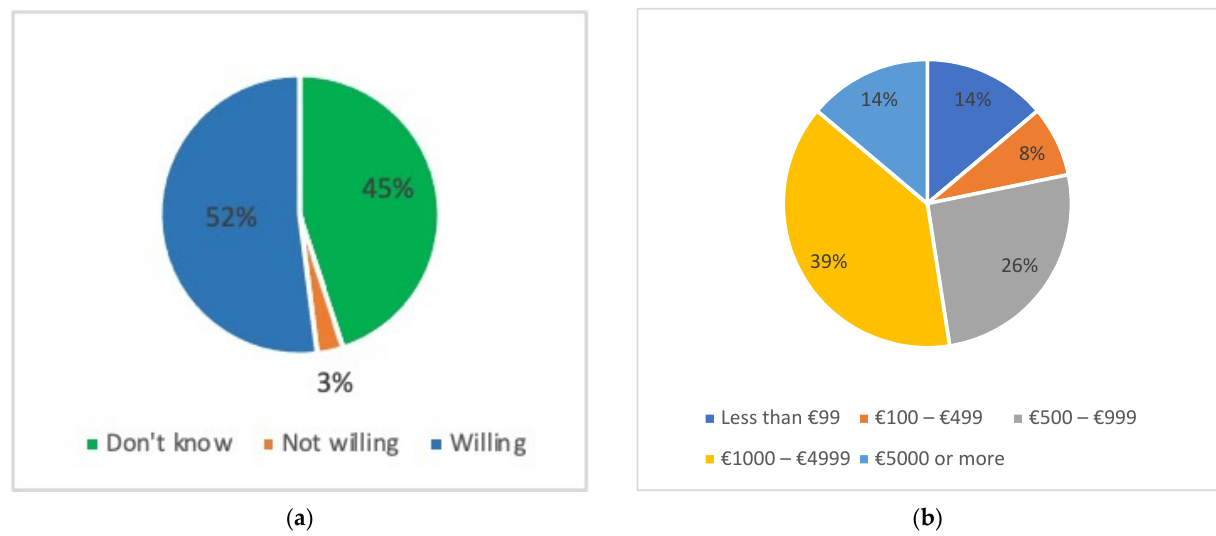
Figure 8. ( a ) Willingness to pay for SG technologies in Inis Mór, Aran Isles; ( b ) Range of payment respondents are willing to make in Inis Mór, Aran Isles.